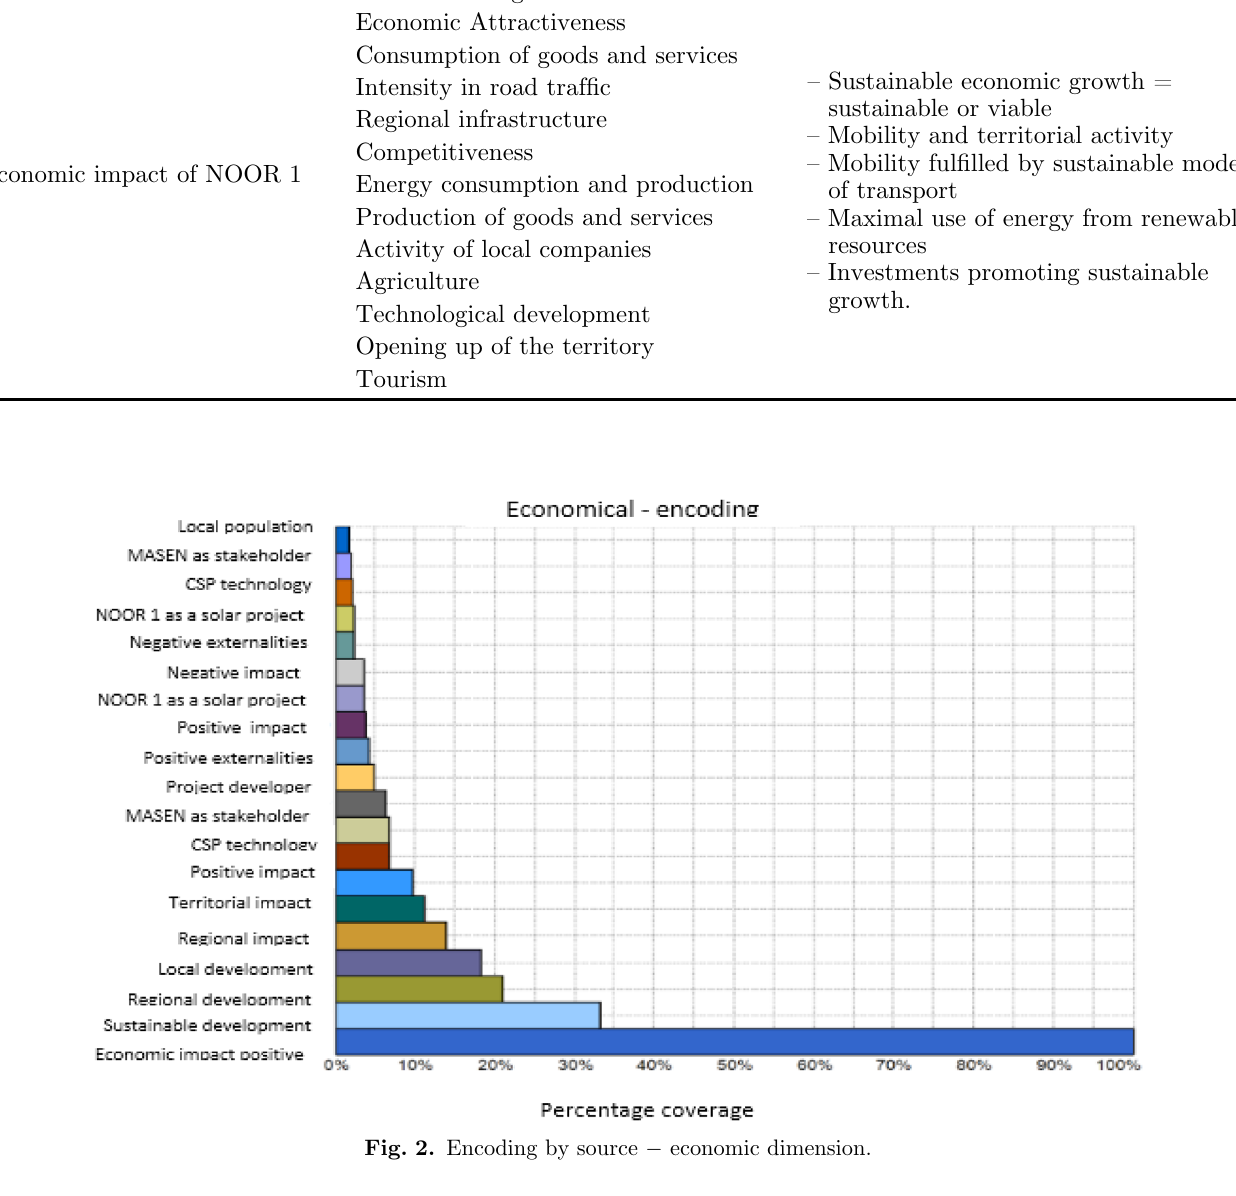
Economic impact of NOOR 1